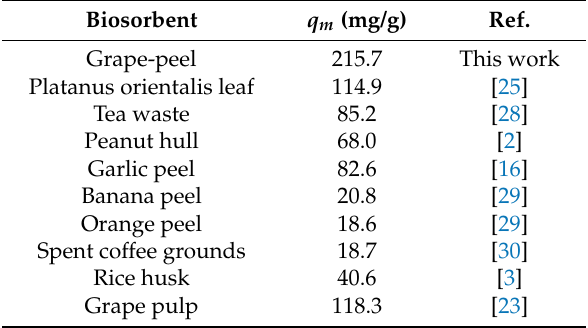
Table 4. Comparison of the maximum monolayer adsorption of MB onto various